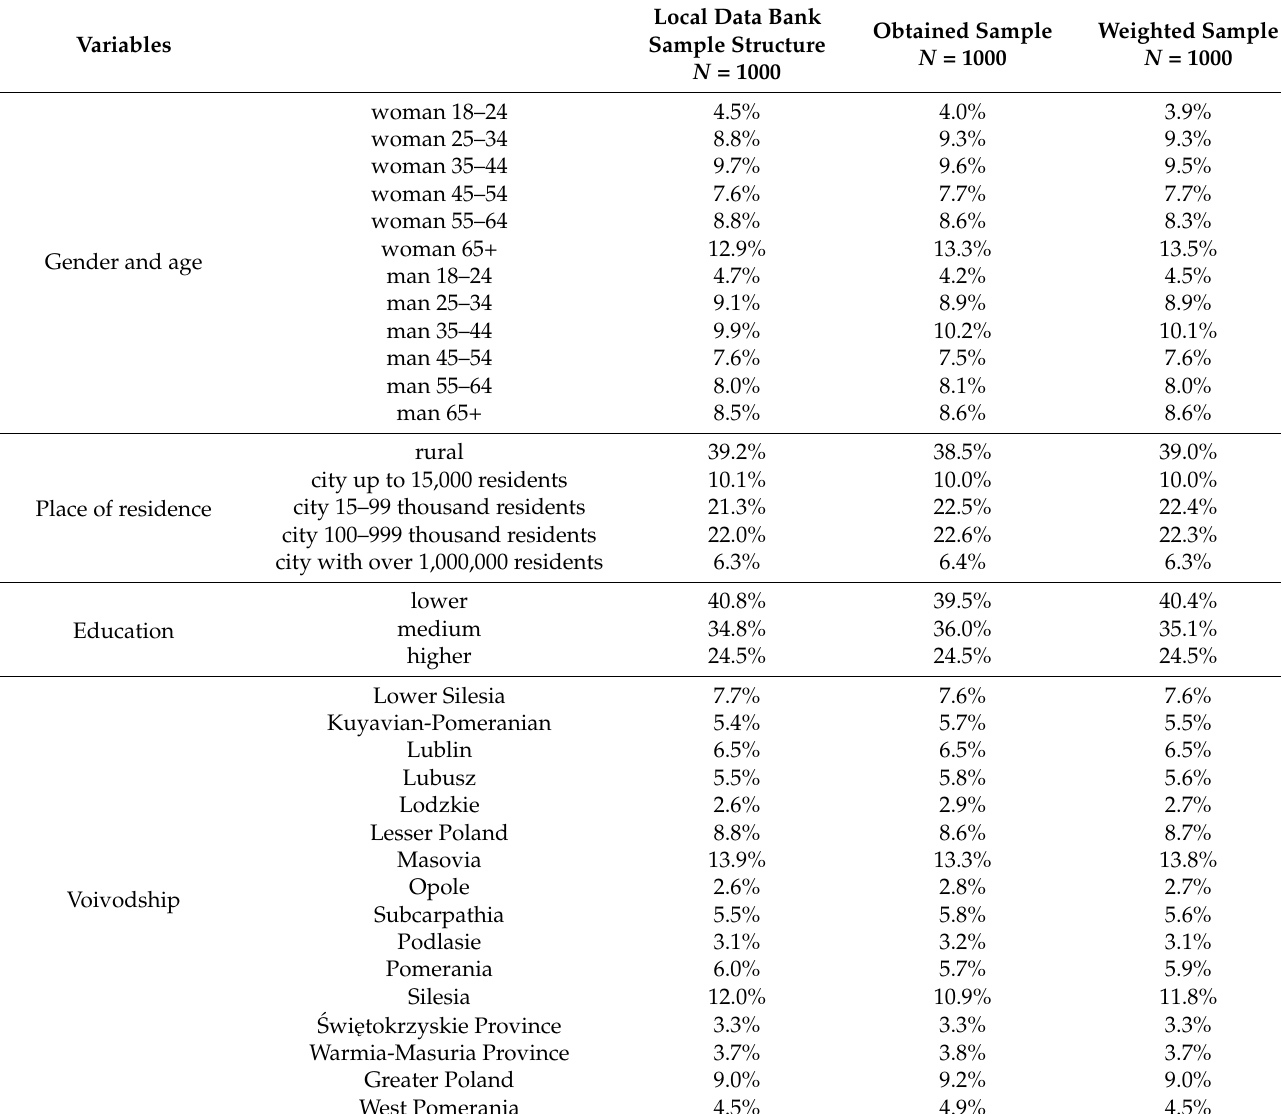
Table 1. Characteristics of the total sample ( N = 1000).